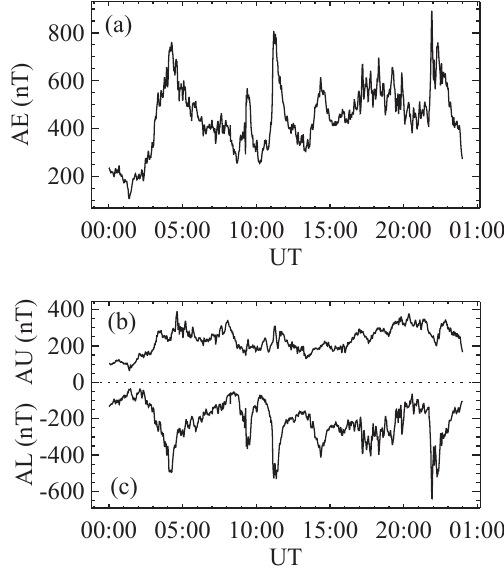
Figure 4. (a) Net reconnection voltage, (b) magnetic flux open- ing rate and (c) magnetic flux closure rate deduced from SI12 and SuperDARN observations on 3 January 2001. The net voltage in panel (a) is the sum of those in panels (b) and (c) .